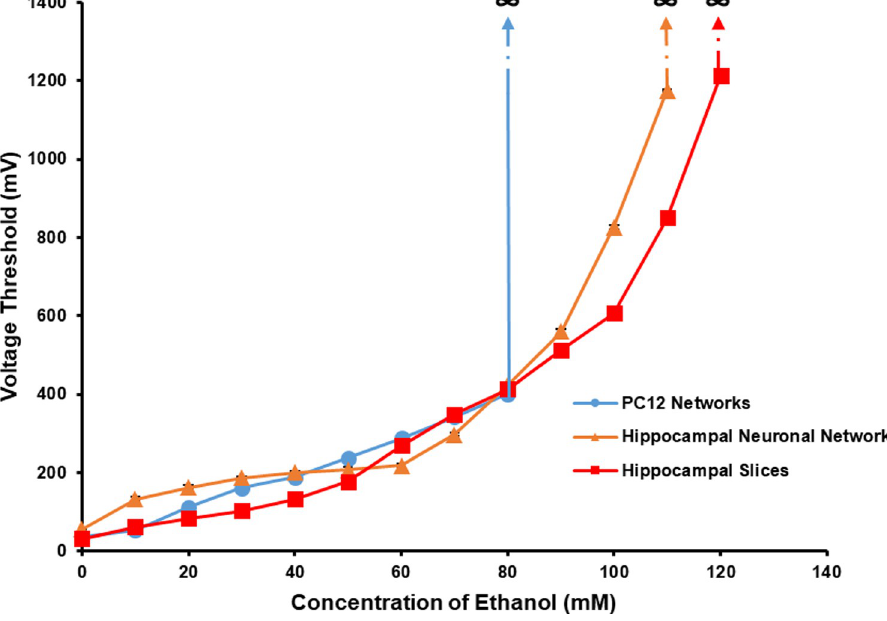
Fig 8. The V Th of the three types of neuronal networks under the effect of ethanol in different concentrations ( n = 5).